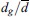
RT-PCR Validation of Differential Expression.
A: comparison of relative expressions of five genes in PAS-seq to their relative expressions in qRT-PCR. In PAS-Seq data, relative expression of a gene is defined as dg/d¯ where dg=n¯gt−n¯g0, d¯ is the averaged value of d
g over three replicates, g = UBL3, MST123, CD47, KIAA0465 or TESK2, n¯ is the averaged count of reads over three replicates and t = 48 hours of stimulation. The-ΔΔCT method was used for representation of qRT-PCR data and TBP (TATA binding protein) was used as a reference. B: Relative expression variation coefficients of the five genes in PAS-seq and qPCR data. Relative expression variation coefficient is defined as VCgt/VC¯t where VCgt=n¯gt/sgt and VC¯t is the averaged variation coefficient over all selected genes at time t of stimulation and s
gt is sample standard deviation of gene g at stimulation time t.